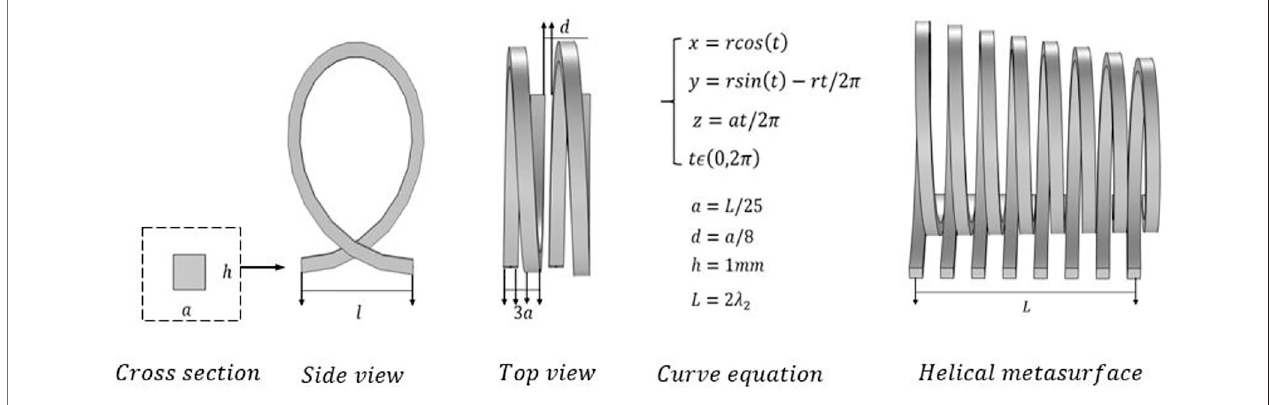
FIGURE 3 | Helical metasurface structural